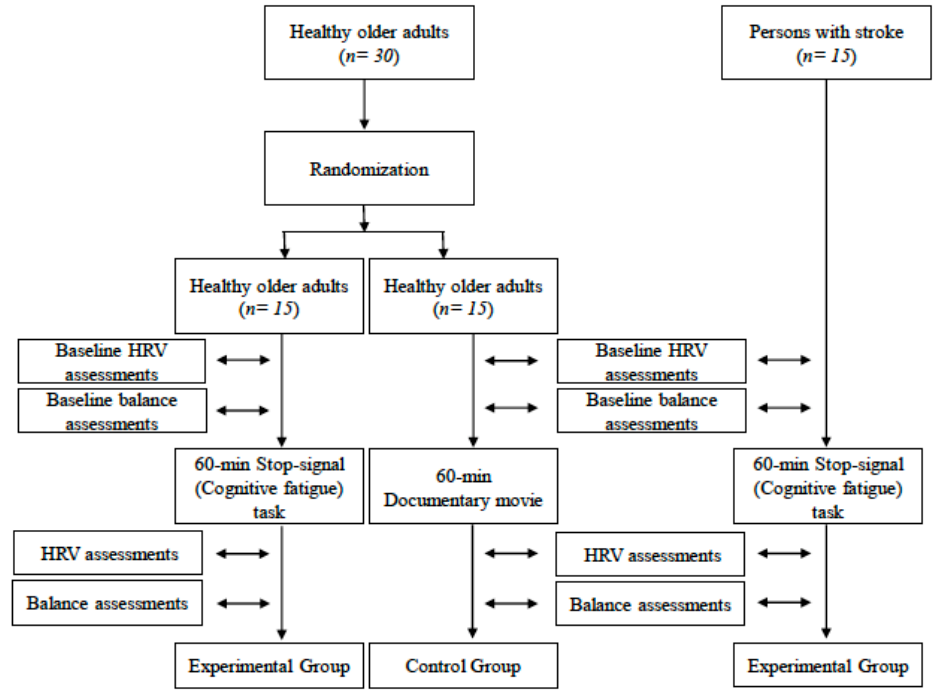
Figure 1. Experimental protocol scheme. HRV, heart rate variability.